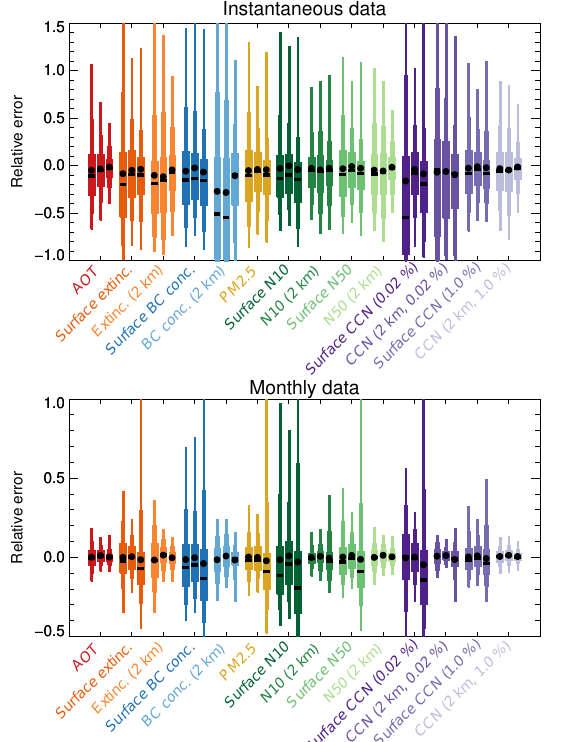
Figure 8. Relative spatial sampling errors (for either instantaneous or monthly data; note the different vertical axes) for all WRF-Chem MADE regions (left bar: W. Europe; centre bar: Oklahoma; right bar: Congo). Further explanation in Sect. 3.2.